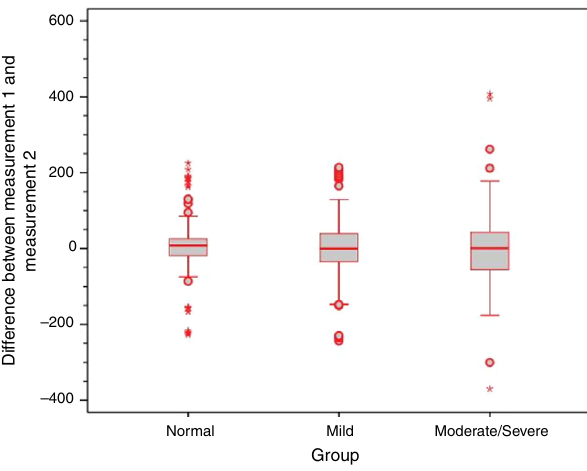
Figure 5 Box plot of differences between time points 1 and 2 for the sniff test in the three study groups.